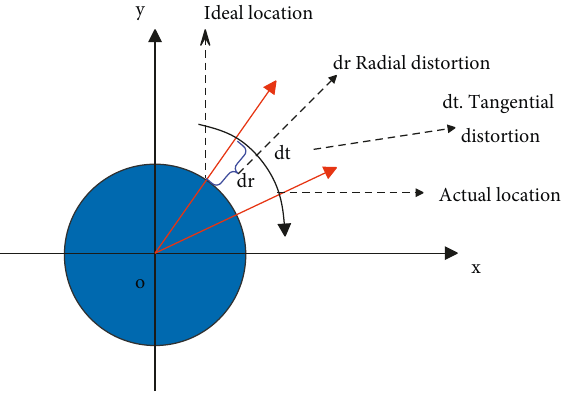
Figure 2: Radial and tangential distortion of the